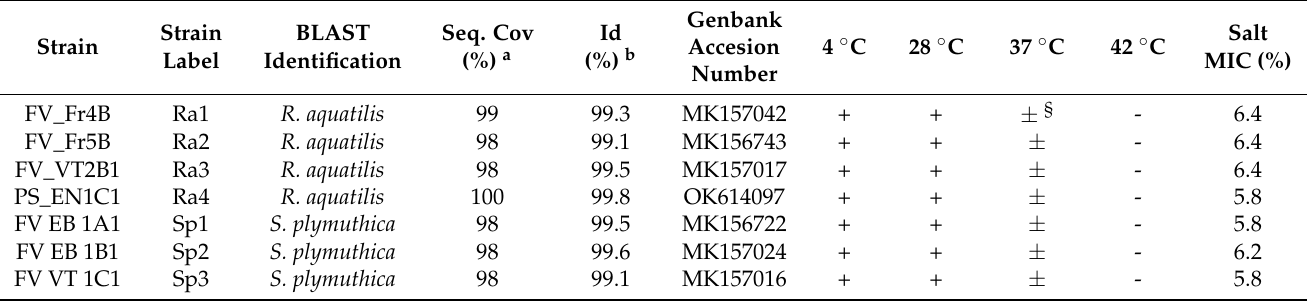
Table 2. Identification, growth capabilities, and salt tolerance of the different strains isolated from fava bean and pea